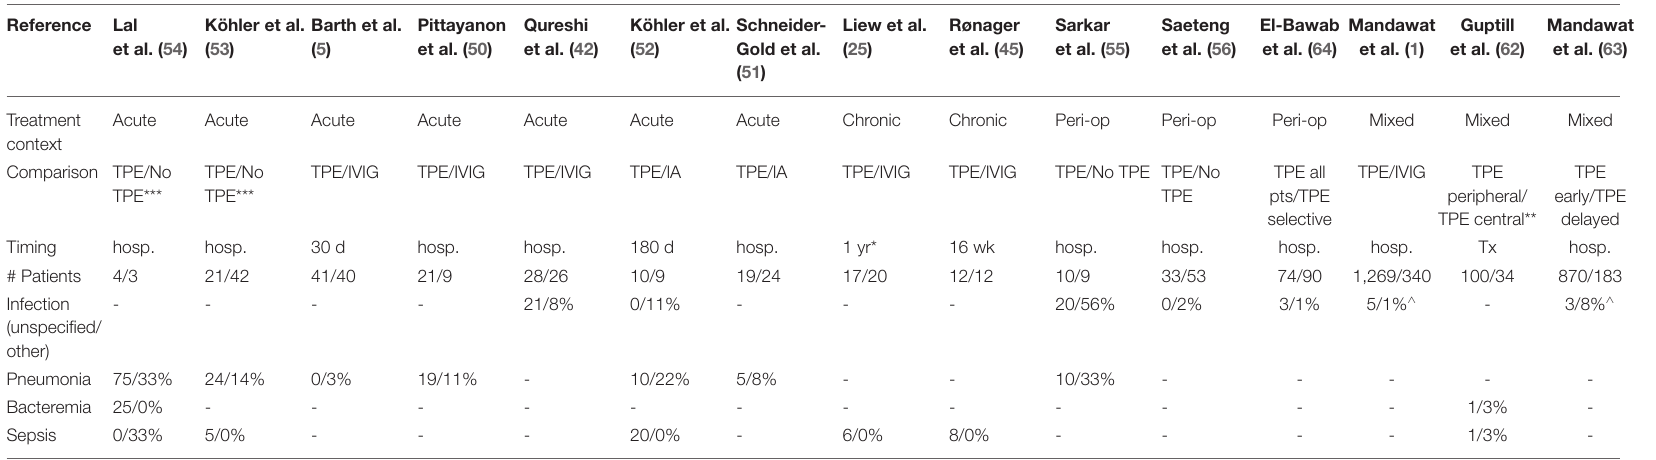
TABLE 10 | Comparative infection adverse event data for TPE in